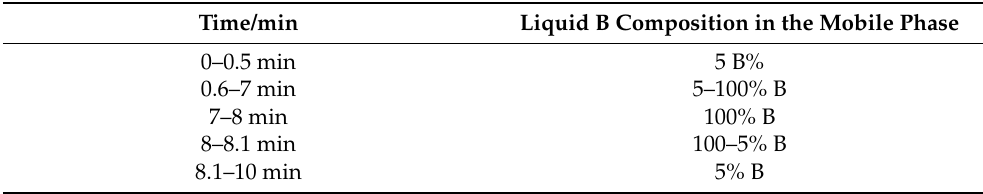
Table 1. HP-LC gradient elution